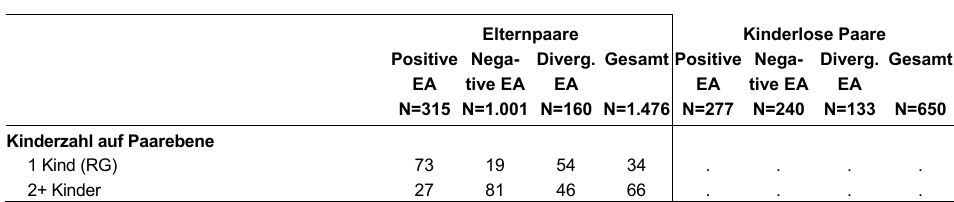
schaftsabsichten, RG =